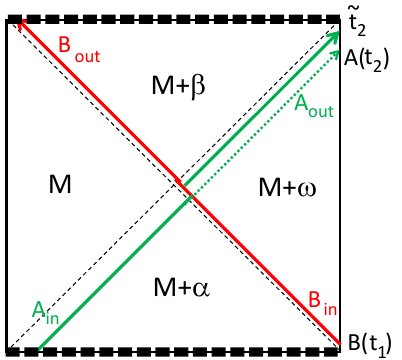
Figure 12 . The R-matrix describes the gravitational shockwave interaction between an infalling and outgoing matter perturbation near a black hole horizon. The particle trajectories divide the space-time into four